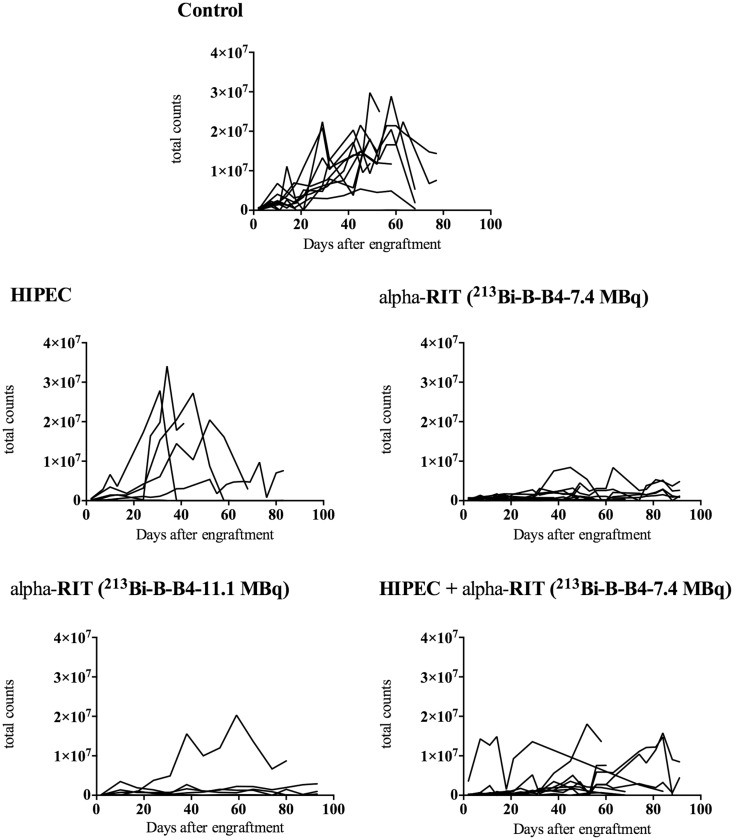
Changes in bioluminescence signal in relation to treatment received. This figure shows changes in bioluminescence signal for each group treated (control n = 11, HIPEC n = 7, alpha-RIT 7.4 MBq n = 11, alpha-RIT 11.1 MBq n = 7, and HIPEC + alpha-RIT 7.4 MBq n = 10) as a function of time (days after engraftment). For each mouse and each time point, the sum of the bioluminescence signal obtained in both the prone and the supine positions is represented.